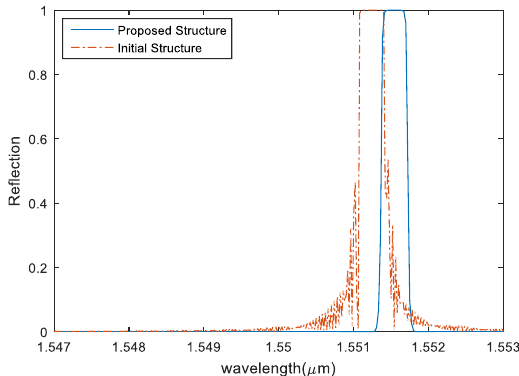
Figure 13: High sensitivity in reflection response of proposed FBG strain sensor at 37 degree Celsius and 1000 micro-strain.